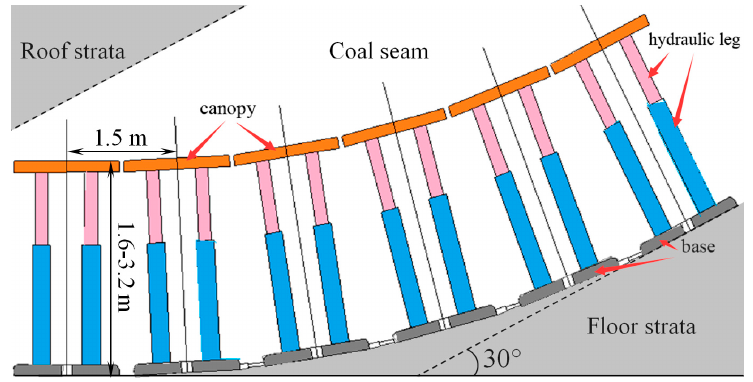
Figure 3. Shield adjustment in an incline-to-flat polygonal-line transitional section.